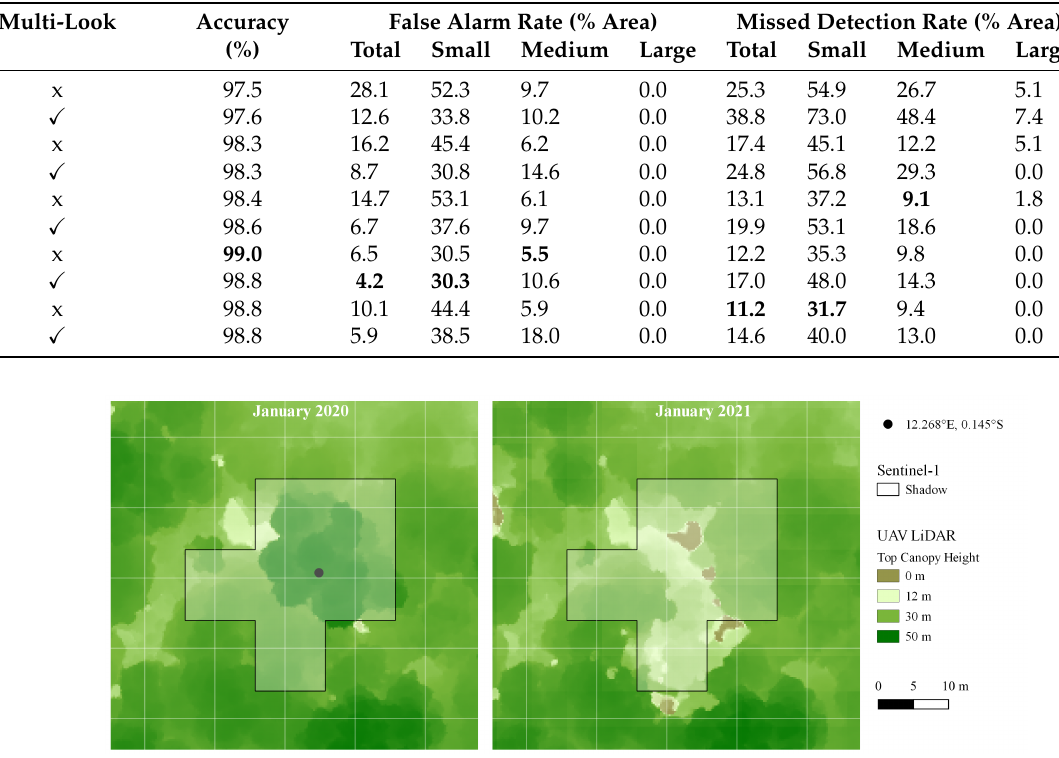
Figure A1. UAV LiDAR Top Canopy Height in January 2020 and January 2021 showing the removal of a canopy tree, overlaid with the area of shadow detected by our S-1